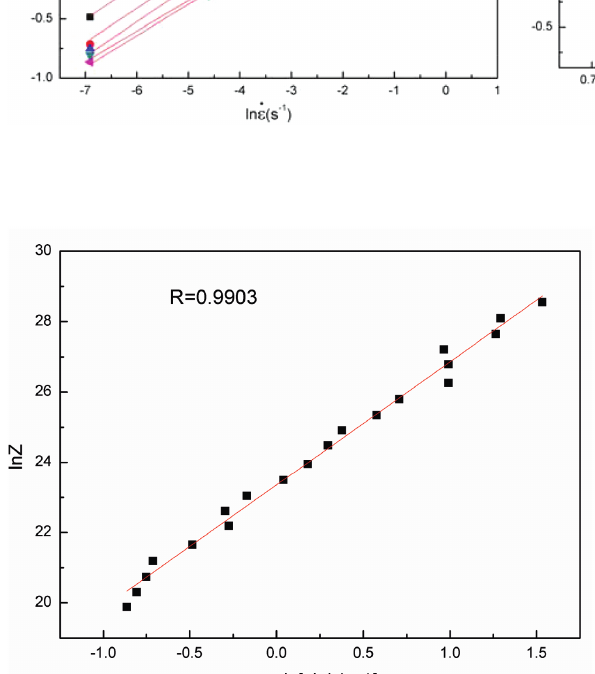
Figure 6: Relationship between ln Z and ln [sinh ( ασ )].